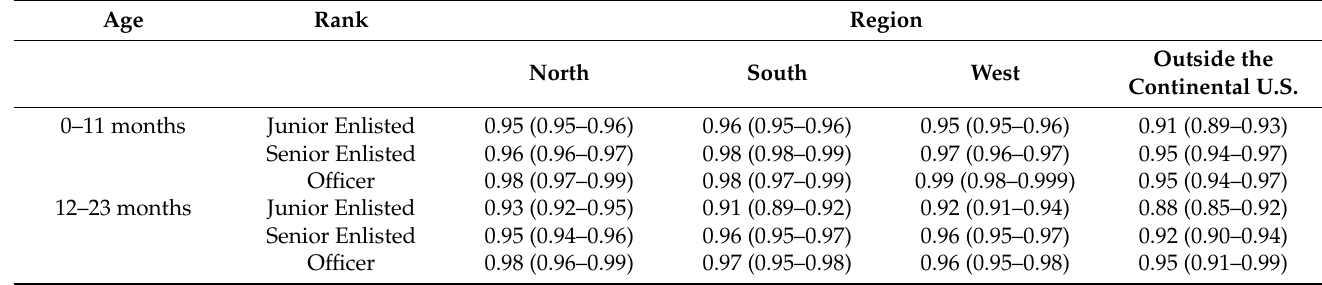
Table 6. COVID-19 versus Pre-COVID-19 Period Rate Ratios for Vaccinations Stratified by Demo- graphic